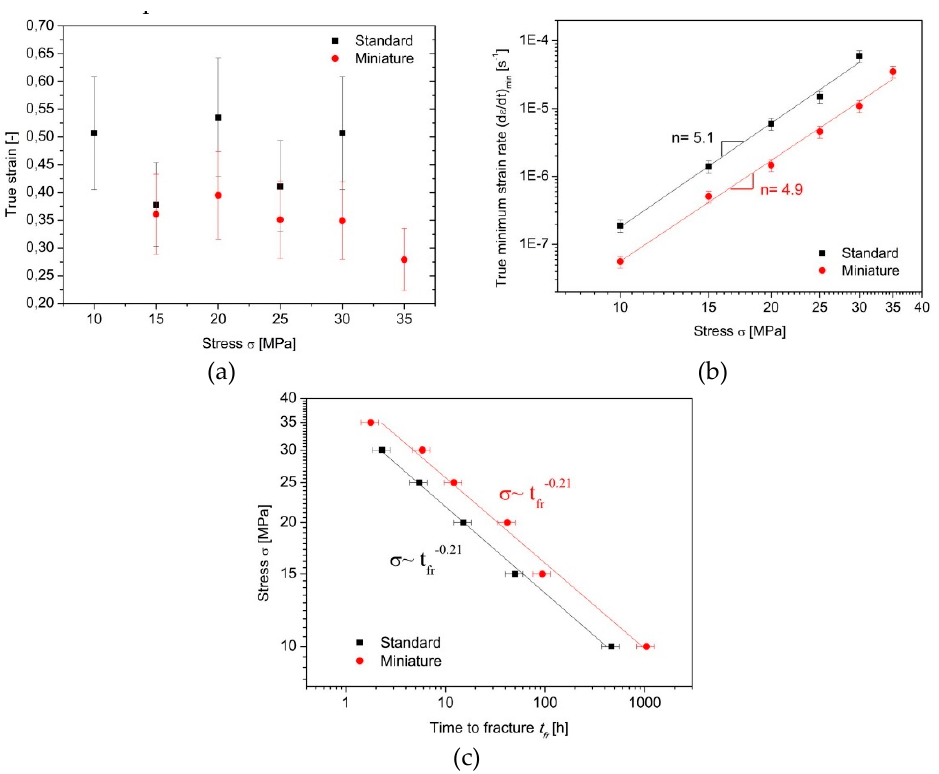
Figure 11. Creep parameter, (a) strain at fracture, (b) Norton-exponent, (c) creep diagram. Lower 𝜺 𝒇𝒓 and 𝜺(cid:4662) 𝒎𝒊𝒏 , higher 𝒕 𝒇𝒓 , shifting of the Norton line and curve of creep rup- ture strength to higher values and lower 𝒁 indicate a higher creep resistance of the min-